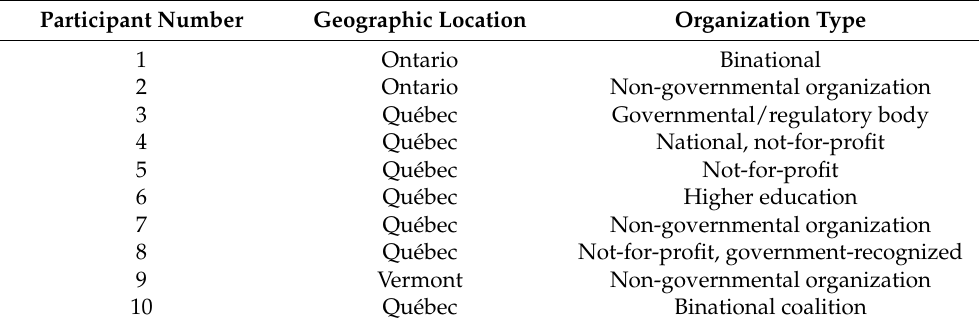
Table 3. Overview of profiles for research